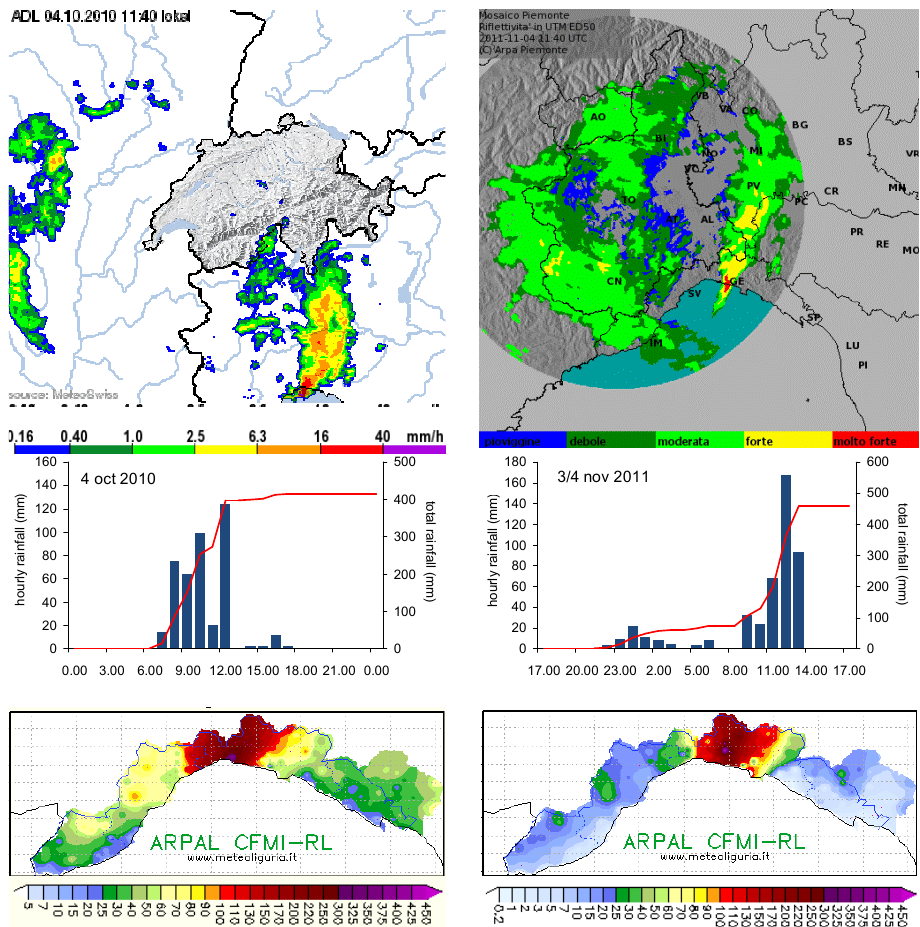
Fig. 3. Radar image, event hyetogram and isohyeth map (24h total rainfall) of 2010 (left column) and 2011 (right column) events in the Genoa municipality and surrounding areas (from Arpa Liguria, Arpa Piemonte and Landi Meteo Swiss Wetter